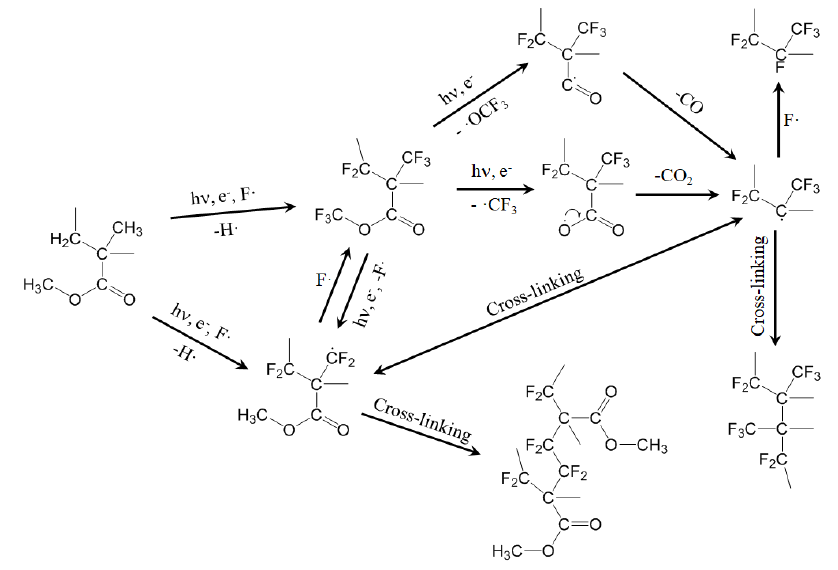
Figure 5. Proposed mechanism for the plasma fluorination of PMMA.